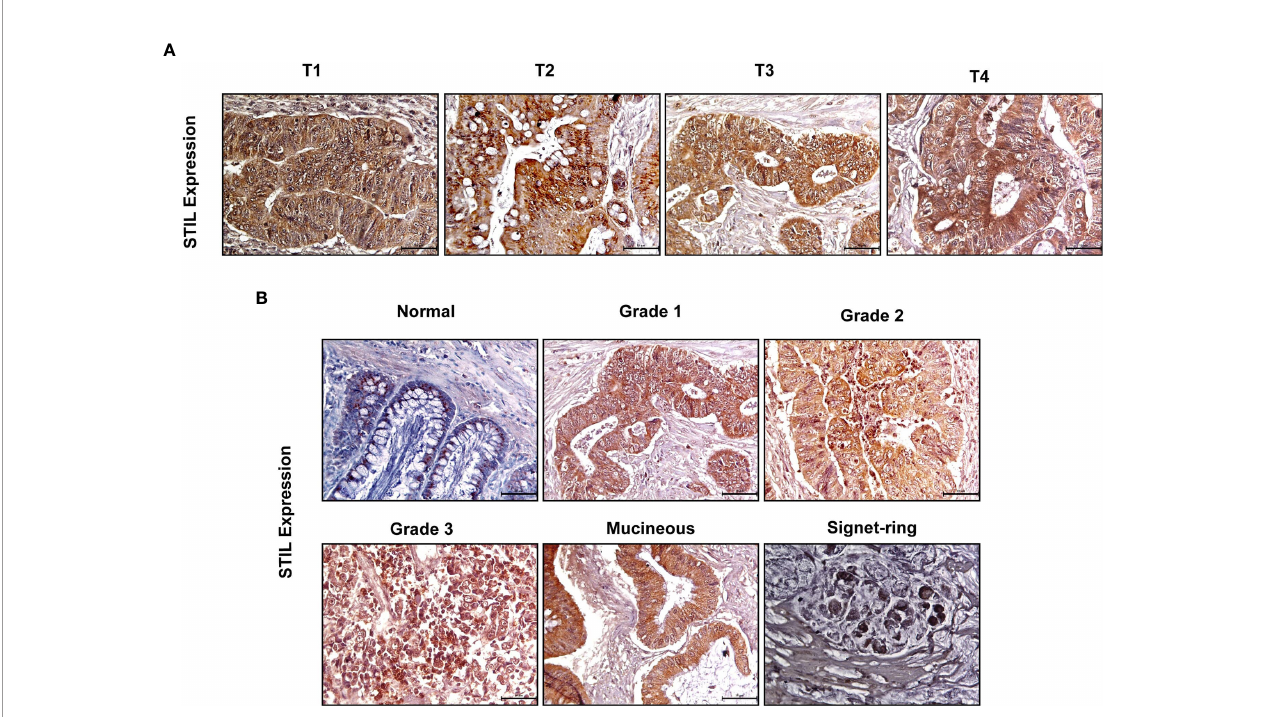
FIGURE 2 | IHC of rectal cancer tissue array showing expression of STIL protein. (A, B) Representative images showing expression of STIL protein in different tumor stages and grades.